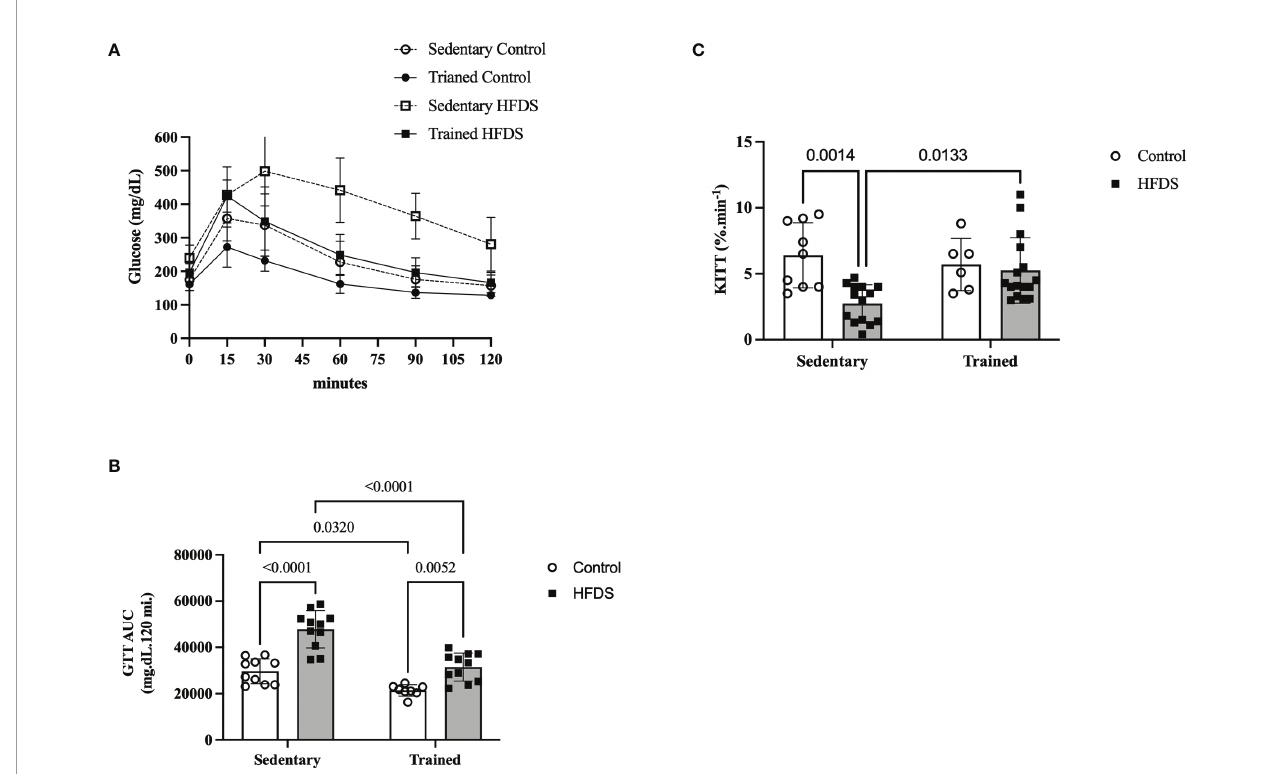
FIGURE 4 | Glucose and insulin sensitivity test following the eight-week intervention in the C, CTR, HFDS and HFDSTR groups. Data were analyzed by two-way ANOVA as described in the Material and Methods. (A) GTT represented by (B) AUC: C vs. CTR; C vs. HFDS; HFDS vs . HFDSTR and CTR vs. HFDSTR (P<0.05). (C) Kitt: C vs . HFDS and HFDS vs. HFDSTR (P<0.01). Data are expressed as the mean ± SD.